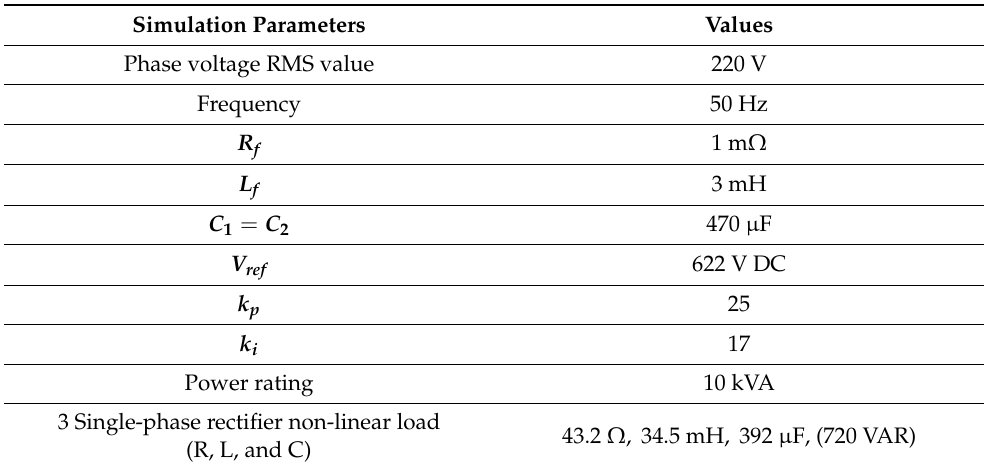
Table 2. Design parameters of Simulated